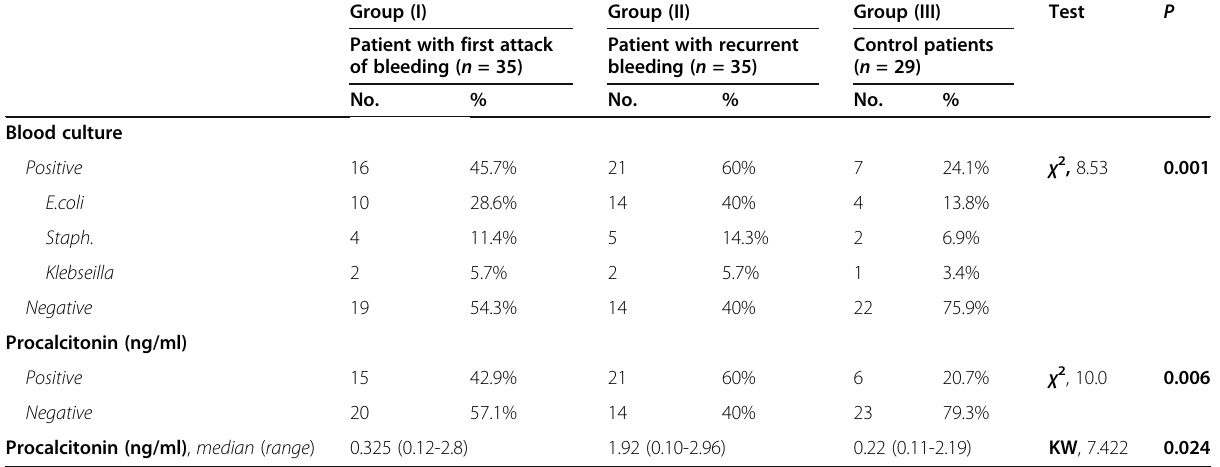
Table 2 Comparison between studied groups regarding bacteremia and procalcitonin results ( n = 99) Group